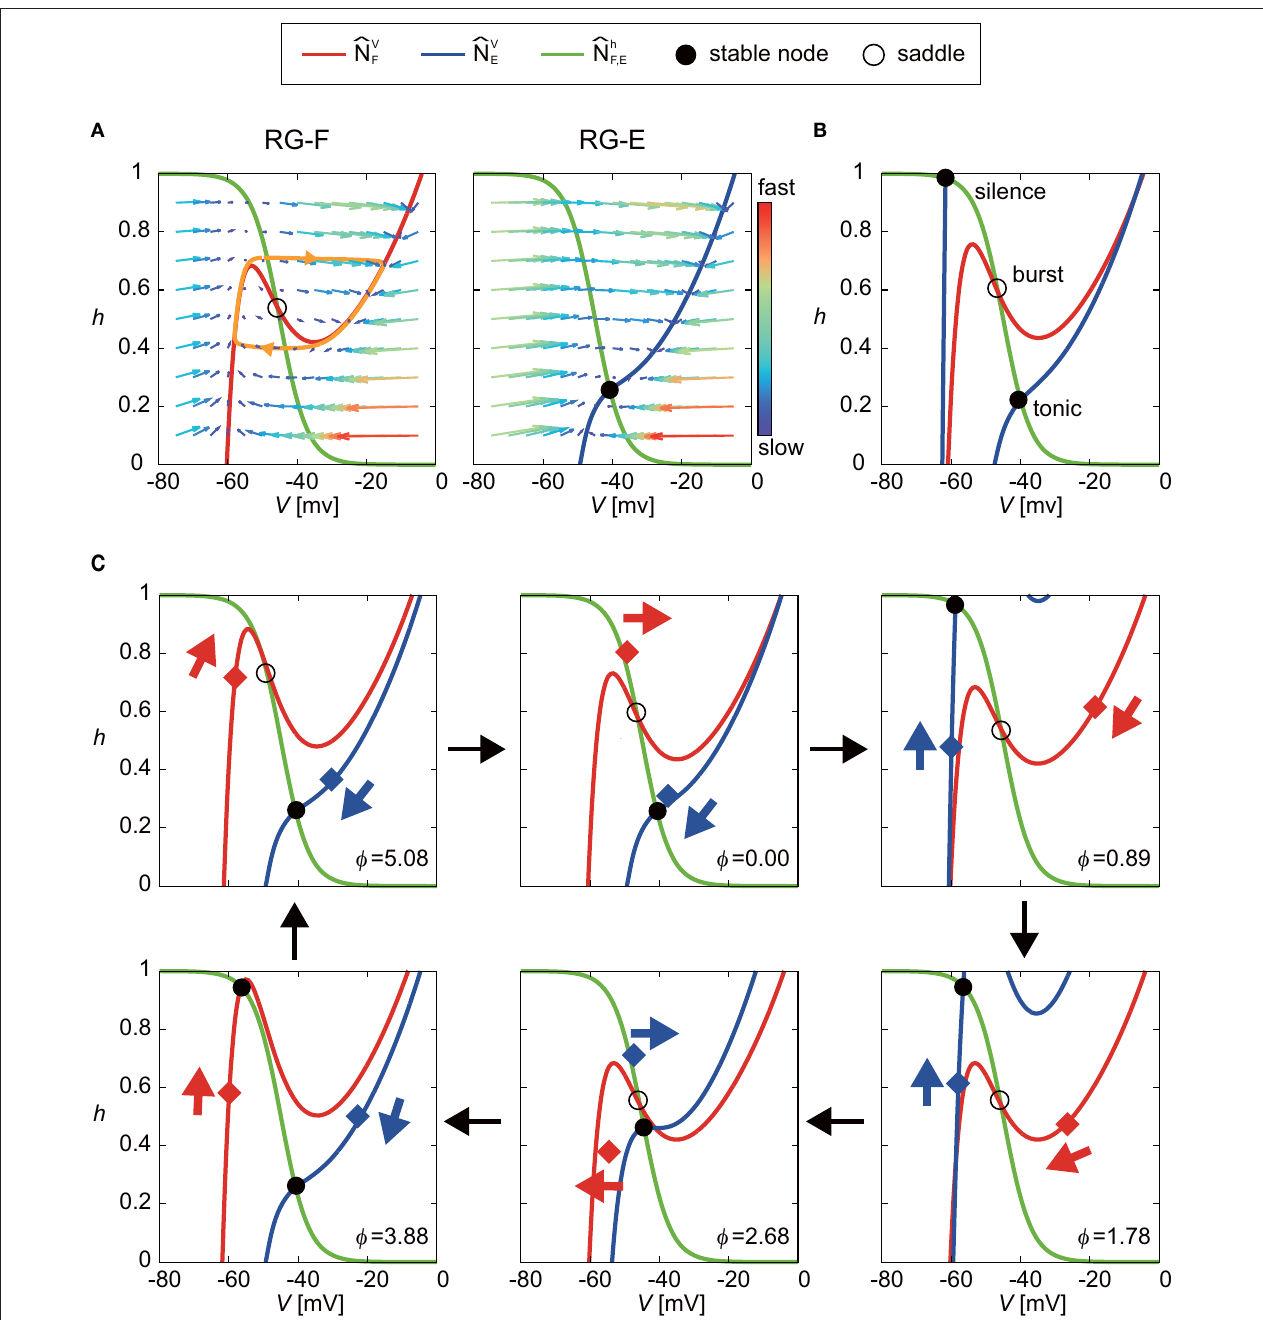
FIGURE 4 | Roles of nullclines of RG-F and RG-E neurons to produce oscillatory behaviors. The green lines show ˆ N h F and ˆ N h E . The red and blue lines show ˆ N V F and ˆ N V E , respectively. Circles indicate intersections of nullclines [filled circles for both negative eigenvalues (stable node) and open circles for negative and positive eigenvalues (saddle)]. (A) ˆ N V F and ˆ N V E with the vector field for the case without synaptic connections from other neurons. The saddle produces a limit cycle (orange orbit) while stable node does not produce any oscillatory behavior. (B) Schematic illustration of changes in ˆ N V F and ˆ N V E induced by synaptic connections from other neurons. The intersection of ˆ N V F and ˆ N h F almost remains saddle (burst mode), which induces an oscillatory behavior. On the other hand, ˆ N V E transitions between two positions depending on the inhibitory signal from the contralateral side. This transition produces oscillatory behavior between tonic and silence modes for the extensor side. (C) Detailed illustration of our model at φ = 0, 0.89, 1.78, 2.68, 3.88, and 5.08rad. Red and blue diamonds are ( V F , h F ) and ( V E , h E ), respectively, and these points move in accordance with eigenvalues, as indicated by